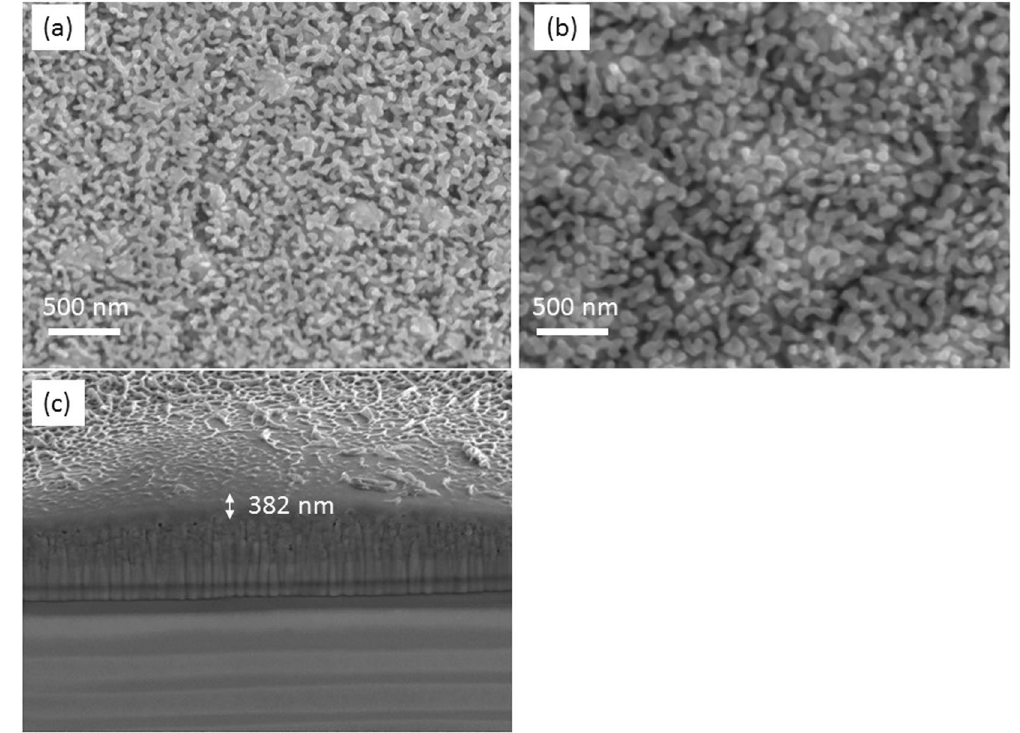
Figure 2. ( a and b ) Top view SEM of LaFeO 3 thin film before and after chronoapeometric test and ( c ) FIB-SEM cross section of LaFeO 3